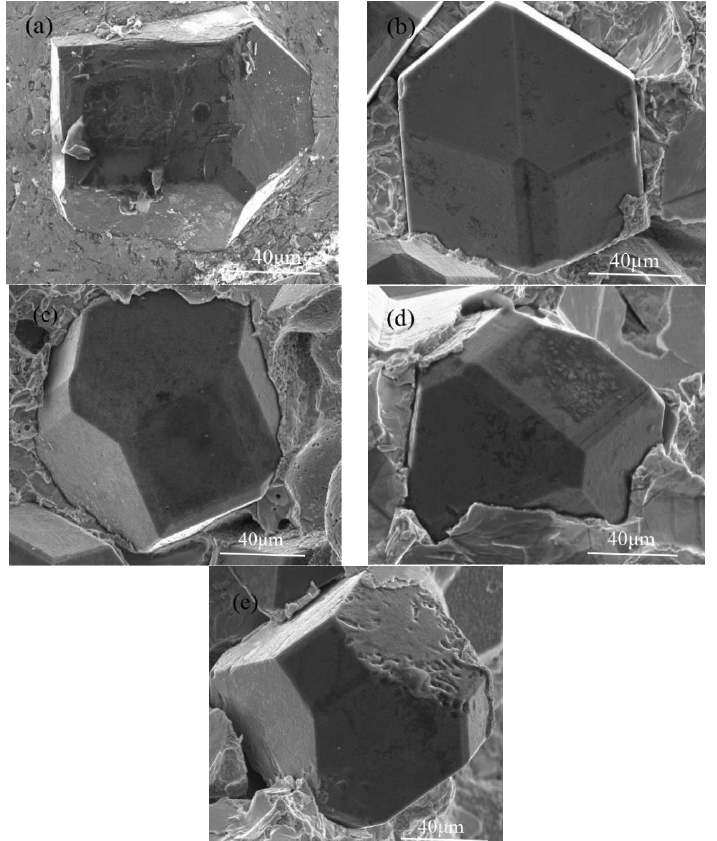
Figure 8. Morphologies of diamond grits brazed with Cu-based alloy containing Ce ( a ) 0 wt %; ( b ) 0.25 wt %; ( c ) 0.5 wt %; ( d ) 0.75 wt %; ( e ) 1.0 wt %. ( b ) 0.25 wt %; ( c ) 0.5 wt %; ( d ) 0.75 wt %; ( e ) 1.0 wt